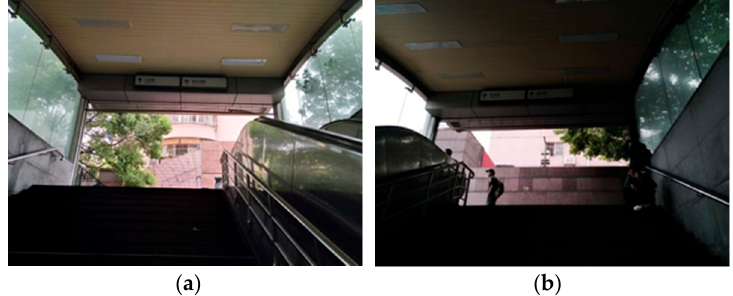
Figure 11. Entrances blocked by the wall. ( a ) The entrance in the southwest end of the underground passageway of Shanghai Railway Station; ( b ) The entrance in the southeast end of the underground passageway of Shanghai Railway Station.